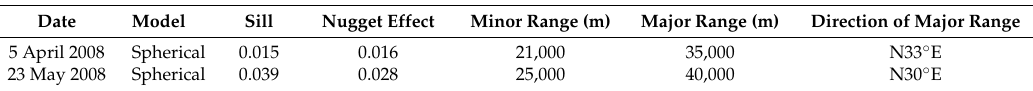
Table 4. Parameters of variogram models innormalized difference vegetation index(NDVI) experimental variograms for the whole study area.